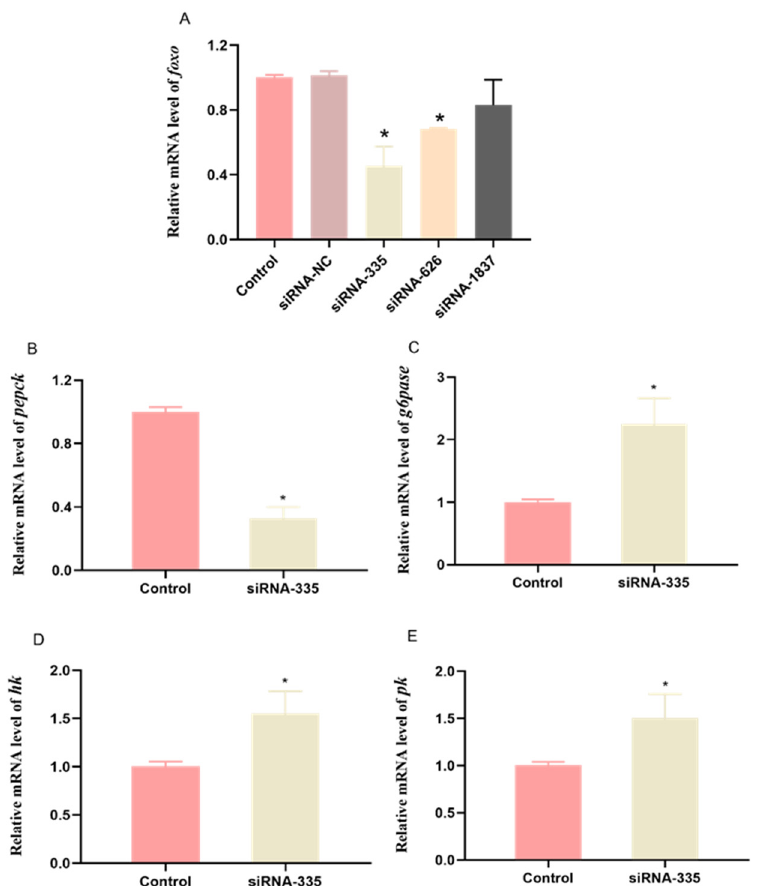
Figure 4. Relative expressions of foxo and glucose-related genes in the hepatopancreas of abalone at 24 h after foxo -specific siRNA injection. The mRNA levels of forkhead box O (foxo ) ( A ), phos- phoenolpyruvate carboxykinase ( pepck ) ( B ), glucose-6-phosphatase ( g6pase ) ( C ), hexokinase ( hk ) ( D ), and pyruvate kinase ( pk ) ( E ) were evaluated using qPCR. Expression values were normalized with expressions of β -actin . Values are represented as mean ± S.E., n = 6. * represents significant difference between control and siRNA-335 groups ( p < 0.05).